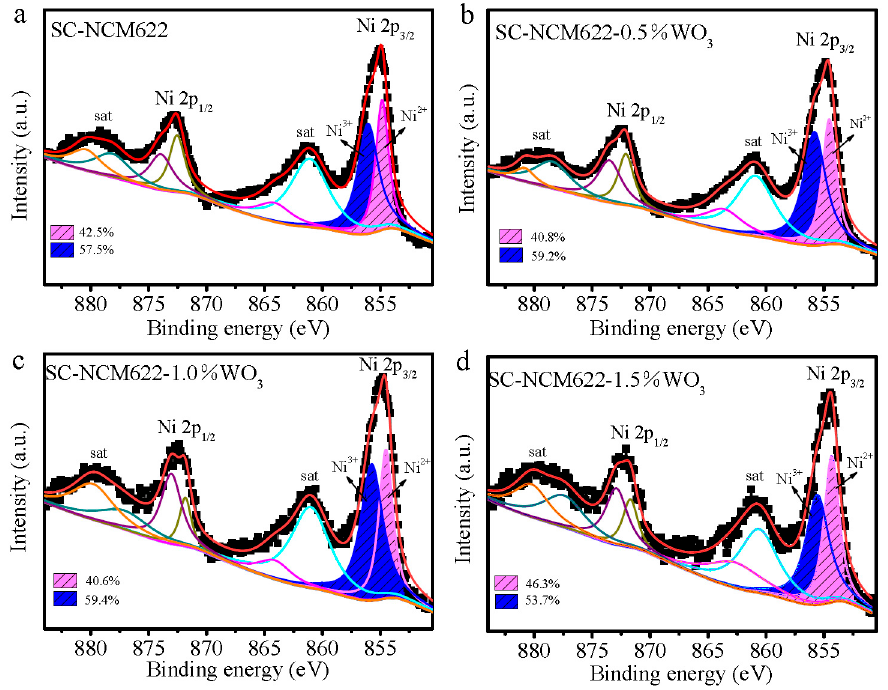
Figure 4. High-resolution XPS spectra and fitting results of Ni 2p for ( a ) SC-NCM622, ( b ) SC-NCM622-0.5%WO 3 , ( c ) SC-NCM622-1.0%WO 3 , and ( d ) SC-NCM622-1.5%WO 3 . 0.5%WO 3 , ( c ) SC-NCM622-1.0%WO 3 , and ( d ) SC-NCM622-1.5%WO 3